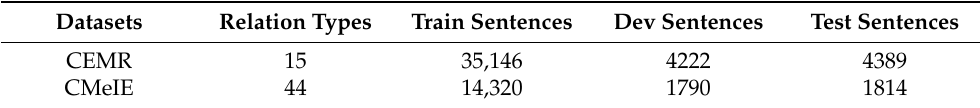
Table 2. Statistics of the datasets.